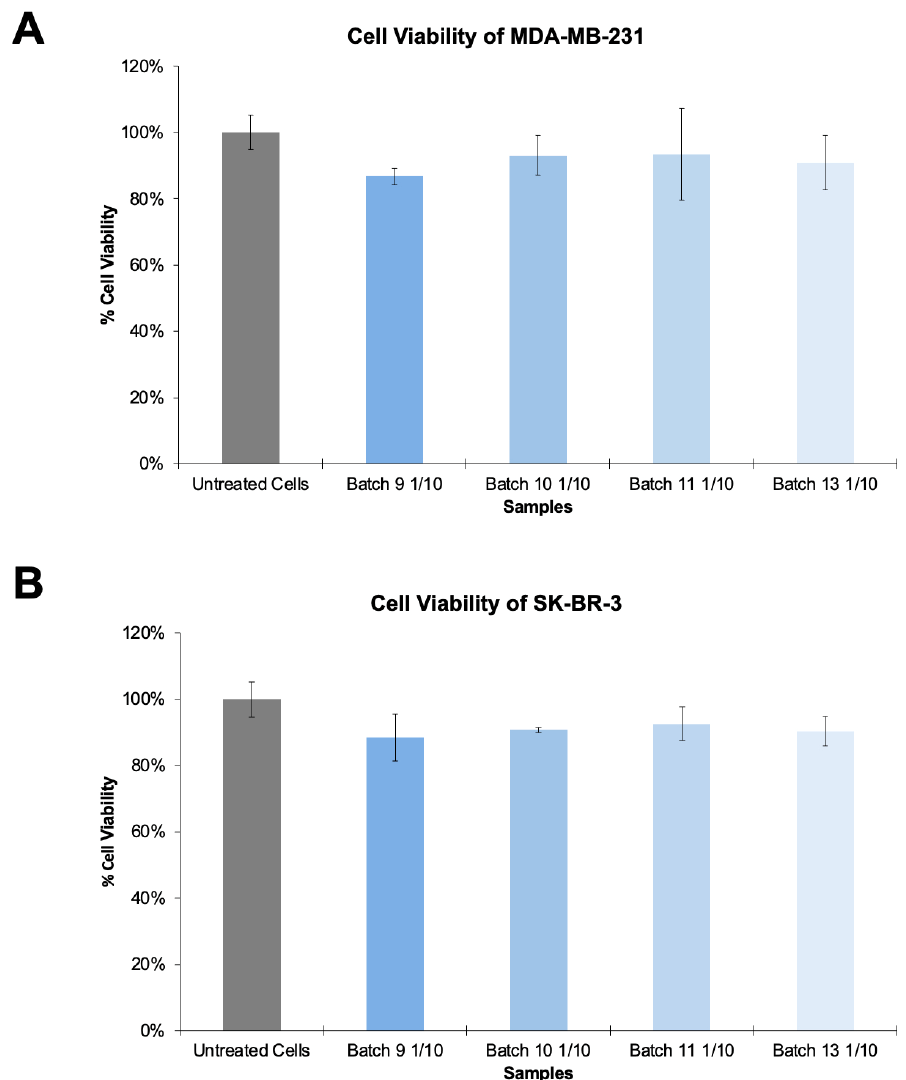
Figure 5. Cytotoxic evaluation of HER2-specific HIV-1-based VLPs. Cytotoxicity assays performed in triplicates in breast cancer cells that lack HER2 overexpression and HER2-overexpressing breast cancer cells. ( A ) Cytotoxicity assay in MDA-MB-231 cells (lacking HER2 overexpression). ( B ) Cytotoxicity assay in SK-BR-3 cells (HER2-overexpressing).